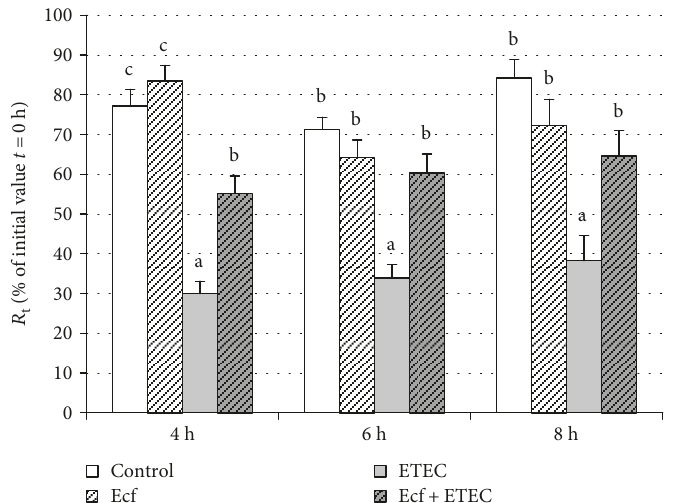
Figure 2: R in cells incubated with bacterial strains (Ecf, ETEC, and Ecf +ETEC) and in control cells not exposed to bacteria [means ± SEM]. t Groups di ff er signi fi cantly ( P ≤ 0 05 ) when marked with di ff erent letters, (e.g., a, b) in the fi gure. N = 5 independent